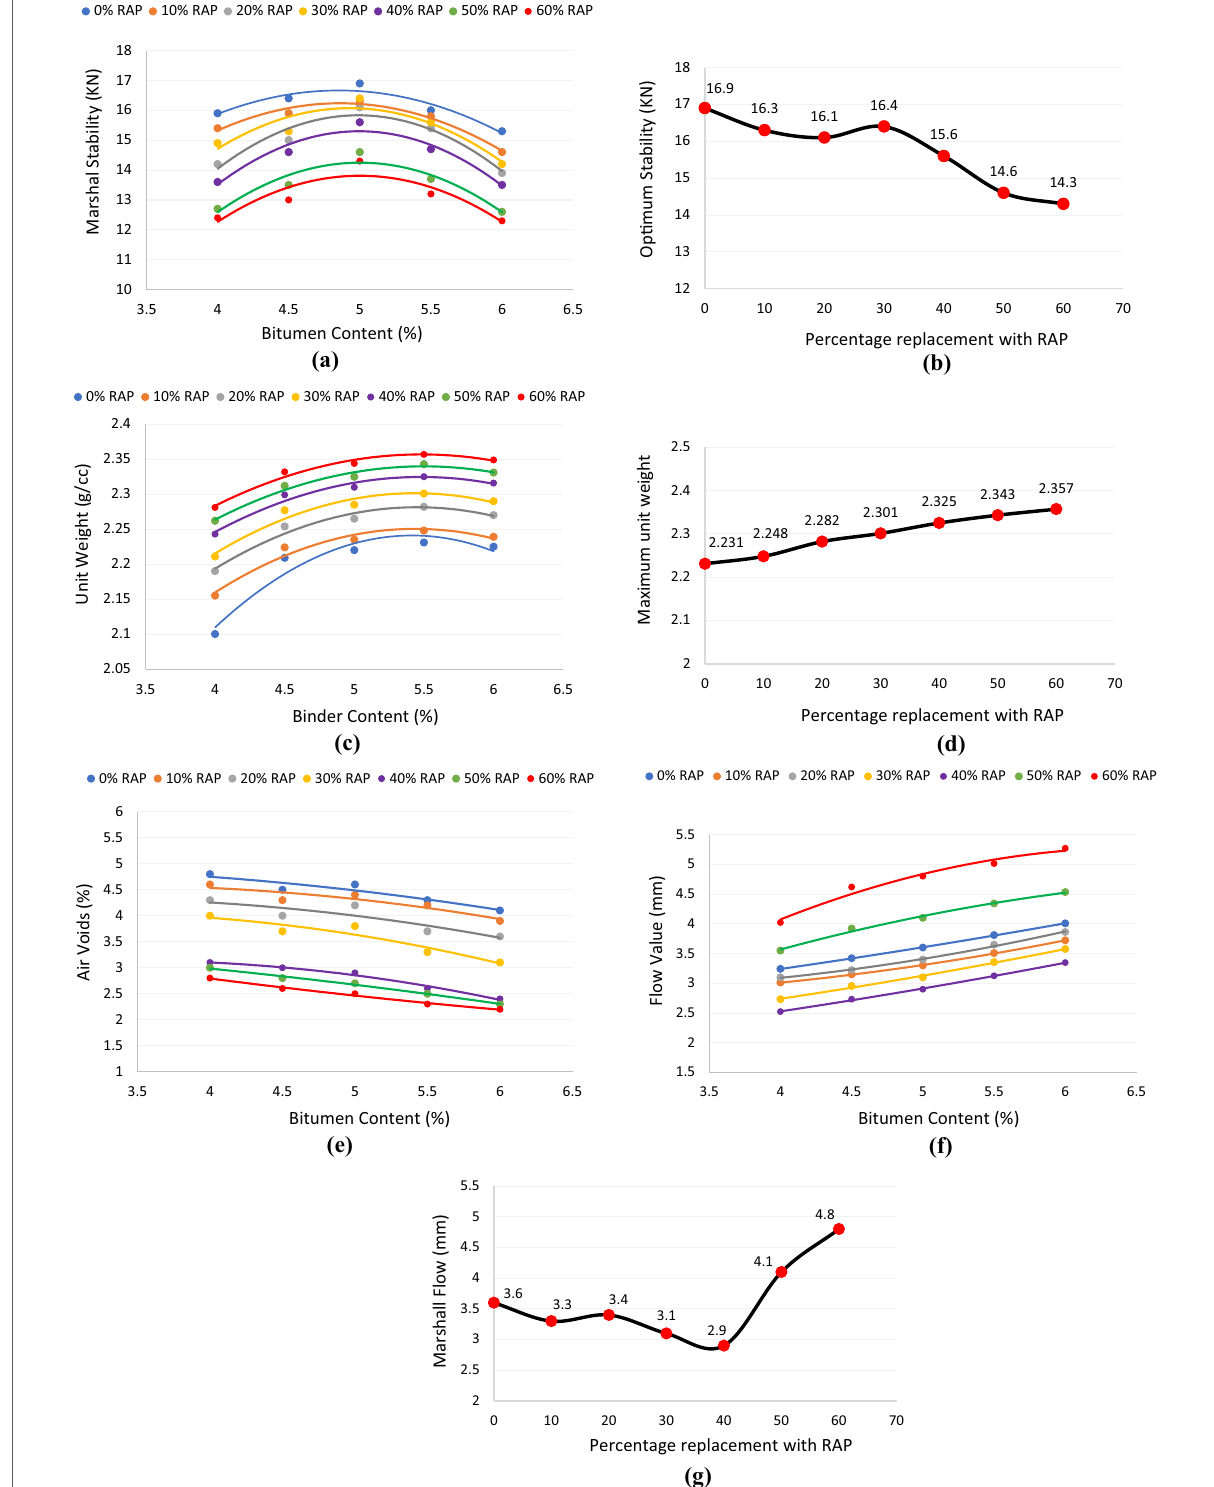
Fig. 5 a Marshall stability versus bitumen content for different mixes. b Variation of optimum stability values for different mixes. c Unit weight versus bitumen content for different mixes. d Variation of optimum stability values for different mixes. e Air voids versus bitumen content for different mixes. f Flow value versus bitumen content for different mixes. g Variation of Marshall flow values for different